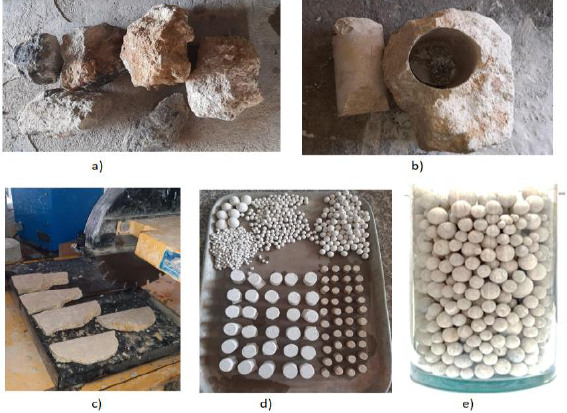
Figure 1. Sequence of transformation activities: ( a ) original rocks of limestones, ( b ) cutting cores for mechanical and elastic tests, ( c ) laminar cutting of rock, ( d ) spherical shaping of particles, and ( e ) grouping of shaped particles to make a cylinder of 100 mm × 200